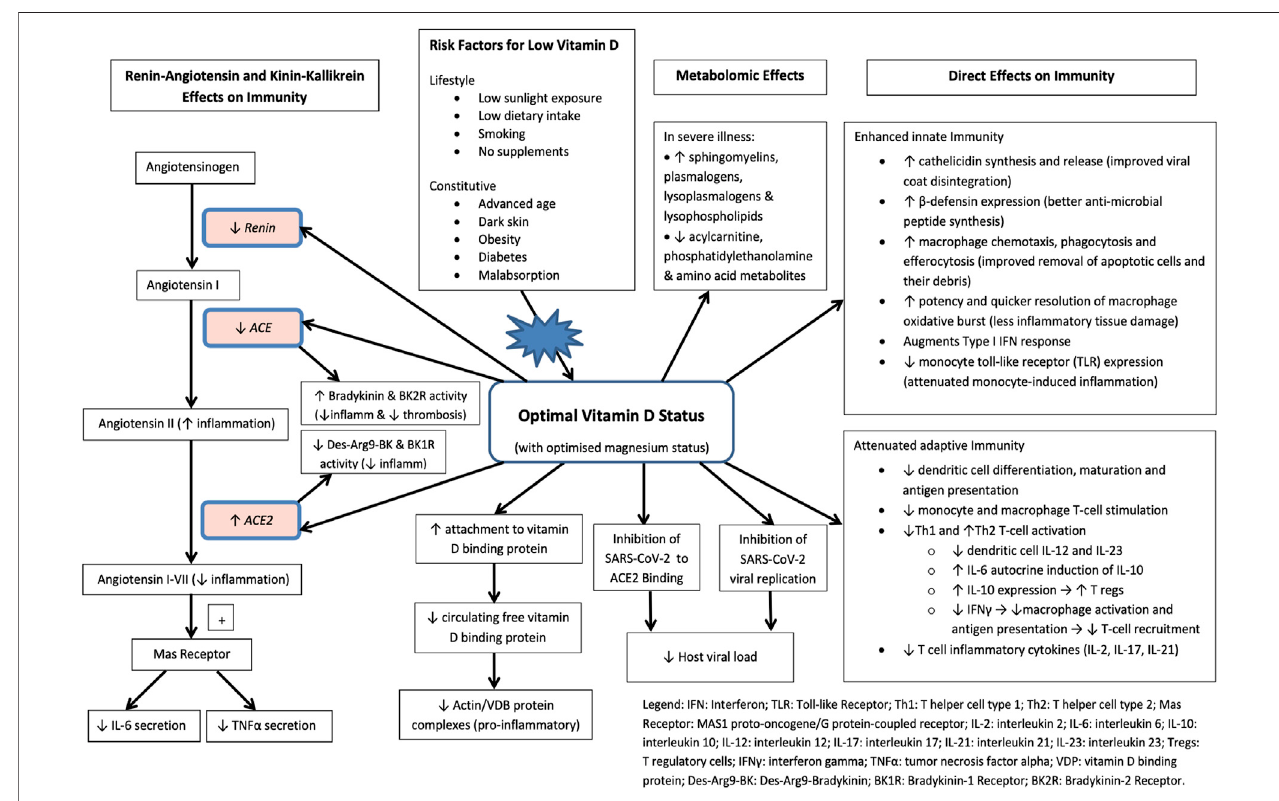
FIGURE 2 | Molecular pathways in the pathology of Covid-19 thought to be affected by vitamin D (adapted from McCartney et al., 2020).